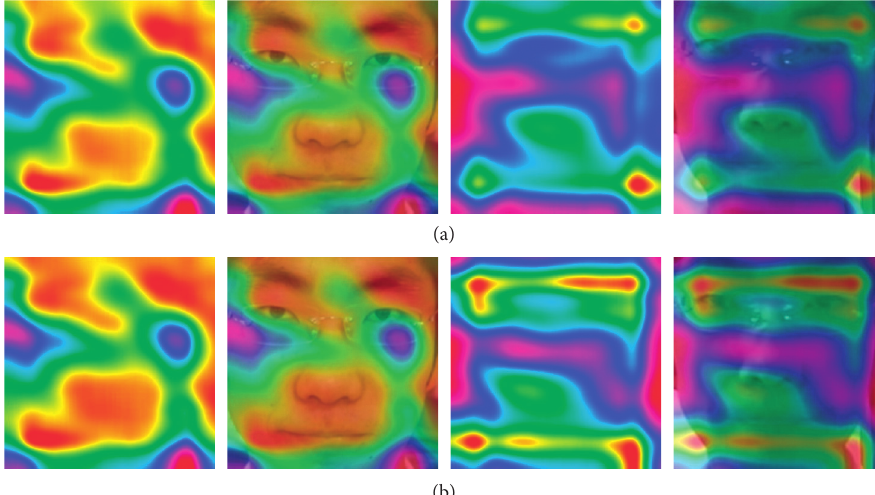
Figure 11: Change in weight heat map before and after spatial attention module: (a) before; (b) after. The spatial attention module pays special attention to some features of the face area.